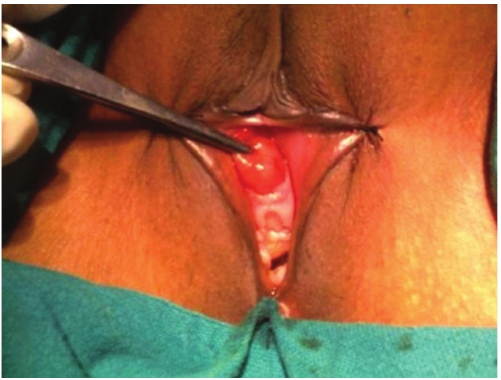
Figure 1: Local examination revealed a 2 × 2cm growth arising from urethral meatus.